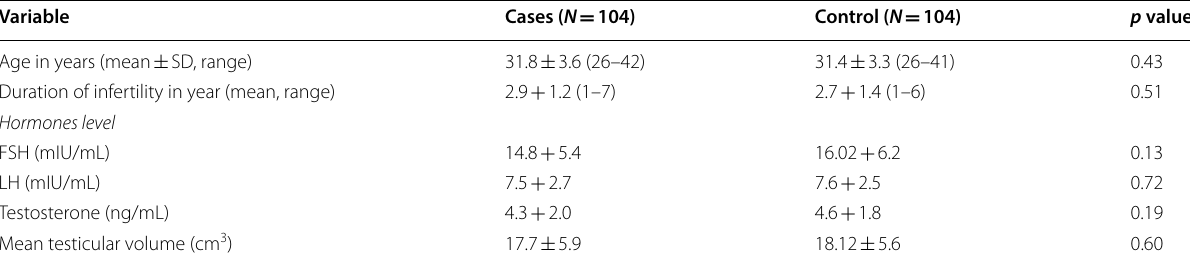
SD Standard deviation ‘ p ’ values calculated using Student’s t test for quantitative variables and Chi-square test for qualitative variables—values less than 0.05 were taken as